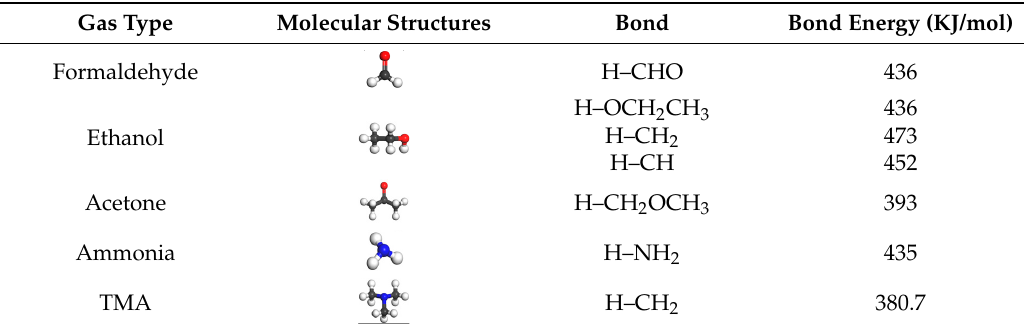
Figure 11. Response comparison of 30 ppm of TMA and 30 ppm of other volatile organic compounds (VOCs) at 260 °C.